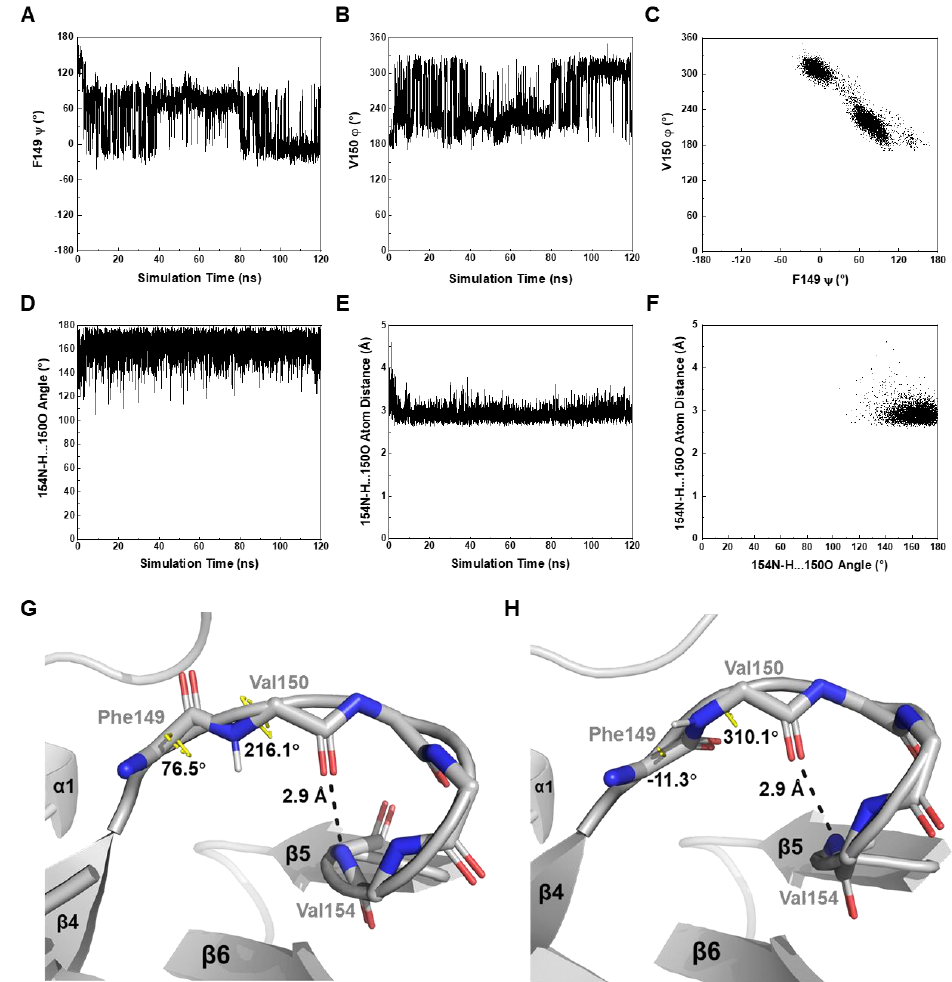
Figure 6. In silico dynamics features of Mtb RimM CTD revealed by MD simulation. ( A , B ) Fluctuations of critical backbone dihedral angle F149 ψ ( A ) and V150 φ ( B ) in the β4-β5 loop. F149 ψ is scaled to (−180°, 180°) and V150 φ to (0°, 360°) to avoid aliases. ( C ) 2D plot of V150 φ vs. F149 ψ. The connec- tion between F149 and V150 adopts two major orientations, as shown correspondingly in the plot. ( D – F ) Stability of the hydrogen bond (V154)N-H…O(V150) indicated in Figure 3D. Both the hydro- gen bond angle ( D ) and hydrogen bond length ( E ) remain almost constant in the MD simulation. The 2D plot of hydrogen bond length vs. hydrogen bond angle ( F ) is also implicated in a stable hydrogen bond. ( G , H ) Structural snapshots for depicting the motion of the β4-β5 loop at two simu- lation time of 78.14 ns ( G ) and 106.10 ns ( H ). V150 φ-F149 ψ exhibits two pairs of typical values, while the downstream helix-like fold undergoes motion as an undistorted entity. Hydrogen atoms are hided except for the V150 backbone amide 1 H atom in each frame.